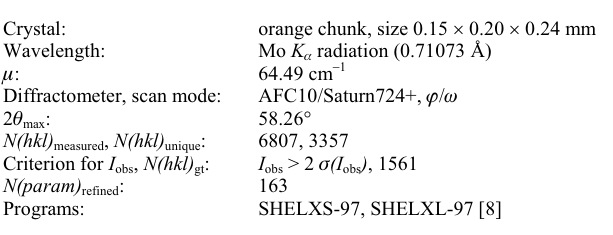
Table 1. Data collection and handling.